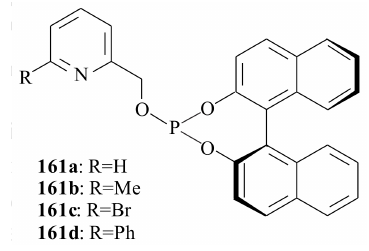
Figure 35. Pyridine-phosphinite